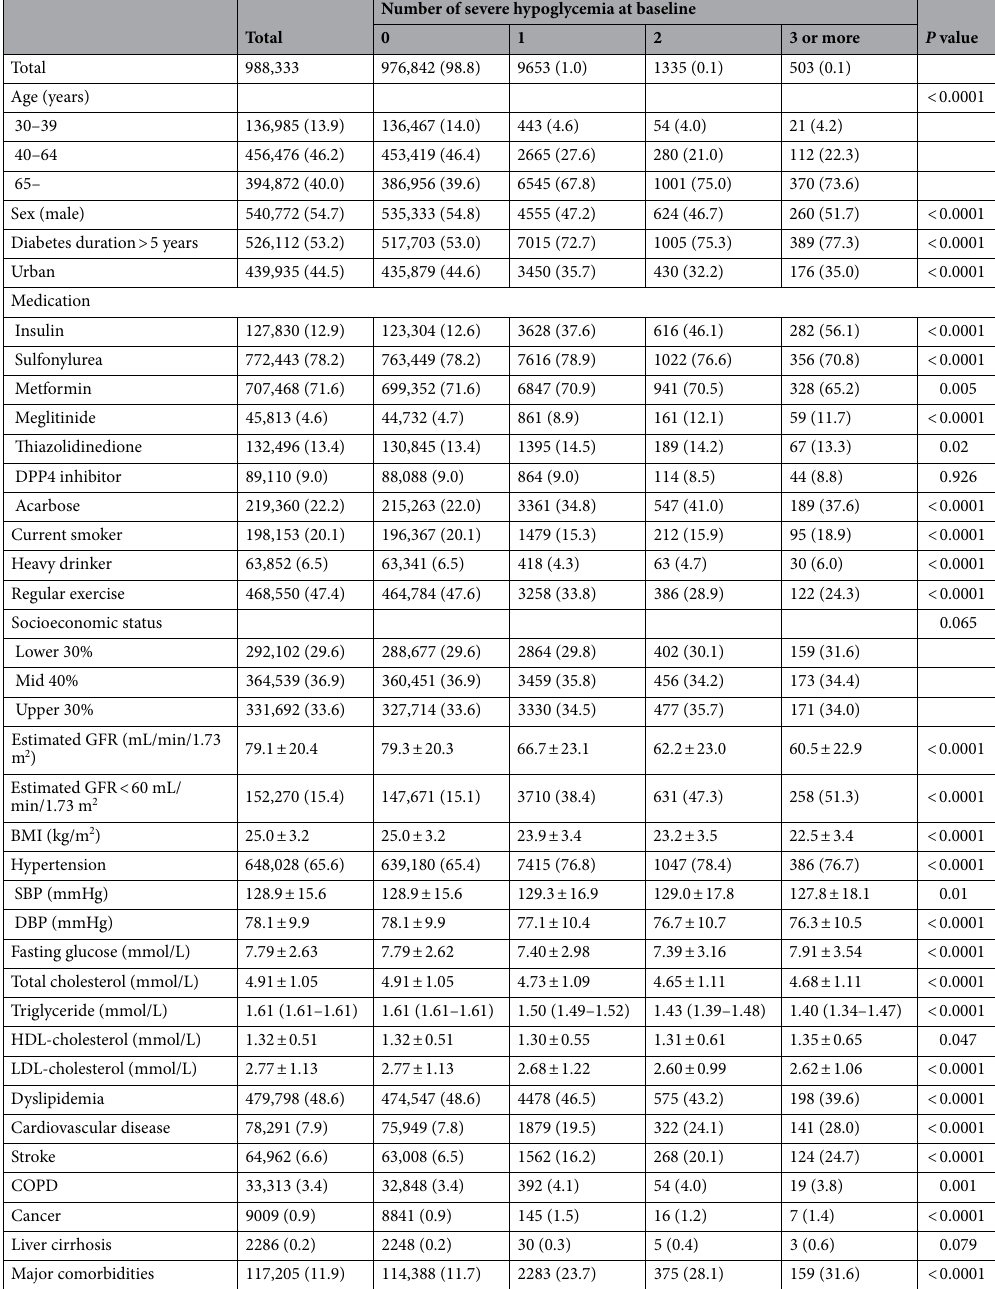
Table 1. Baseline characteristics according to the number of severe hypoglycemia event. Values are presented as n (%) or percentage or mean ± standard deviation. DPP4 dipeptidylpeptidase 4, GFR glomerular filtration rate, SBP systolic blood pressure, DBP diastolic blood pressure, COPD chronic obstructive pulmonary